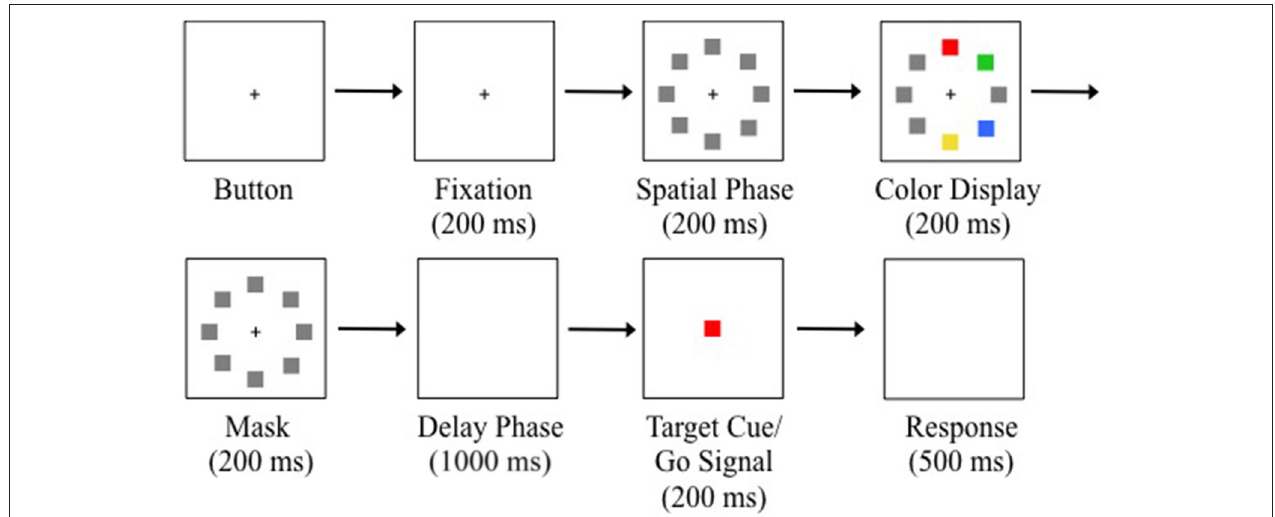
FIGURE 2 | Example trial sequence with a red target. Trials were initiated after button pressing and fixating for 200ms. Gray placeholders then occupied all the potential target positions for 200ms. Four locations were randomly selected to display colored squares for 200ms. The colored squares were masked for 200ms. A blank display was presented for 1000ms to produce memory-guided saccades. The central target cue appeared for 200ms. Offset of the target cue was the saccadic go-signal. Participants were given 500ms to execute a saccade. Note that there was an isolated distractor on this example trial (see Saccade Detection and Data